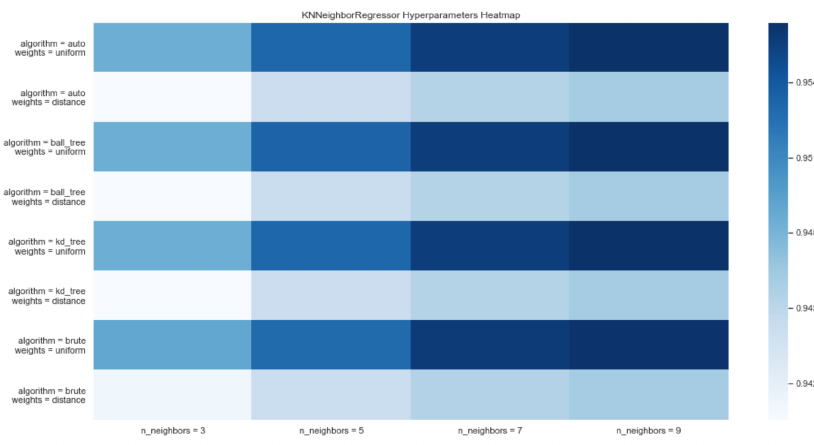
Figure 13. KNNeighborsRegressor Hyperparameter Heat